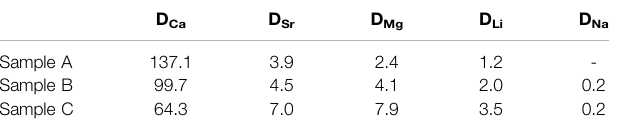
TABLE 2 | Distribution ratio of cations ions in the fi rst extraction stage (1-1). D Ca D Sr